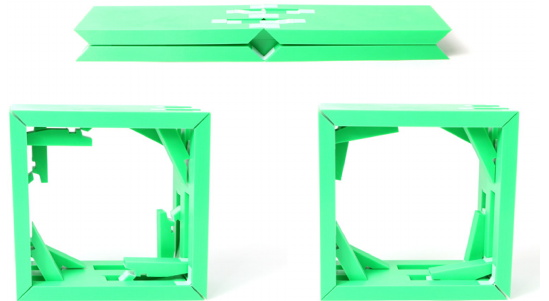
Figure 31. Flat-foldable square unit cell in flat, deployed, and locked